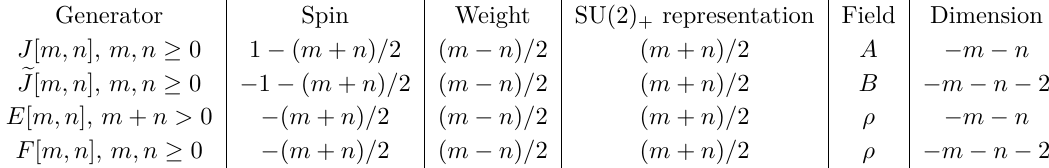
Table 1 . The generators of our 2d chiral algebra and their quantum numbers. Dimension refers to the charge under scaling of R 4